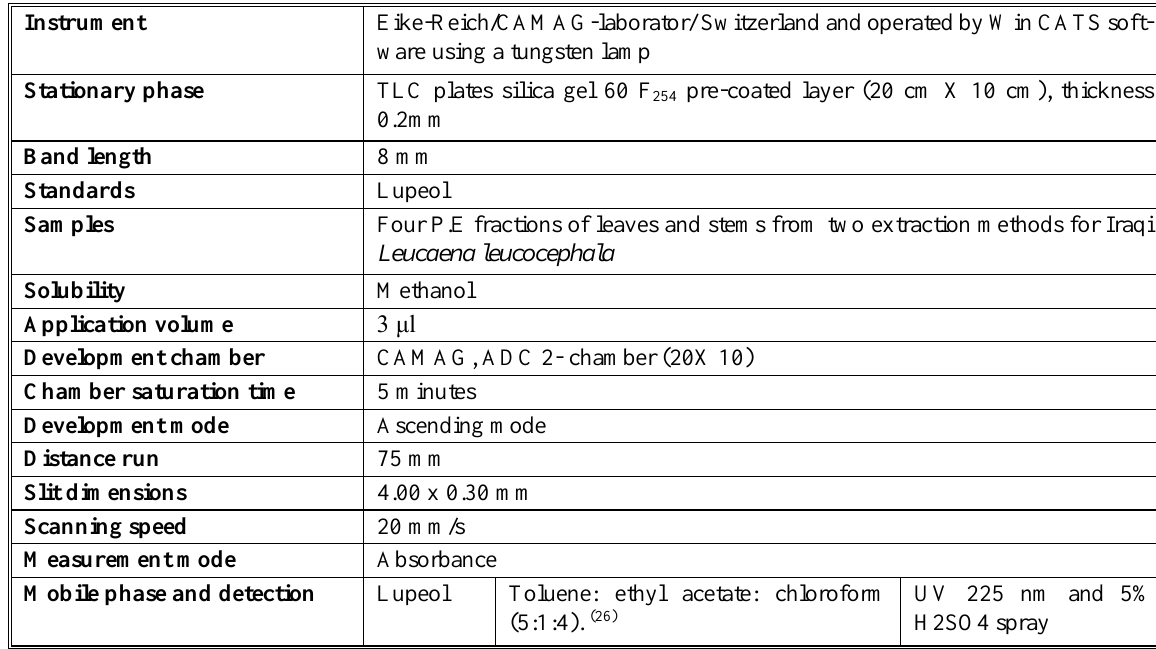
Table 2. HPTLC conditions. (5)